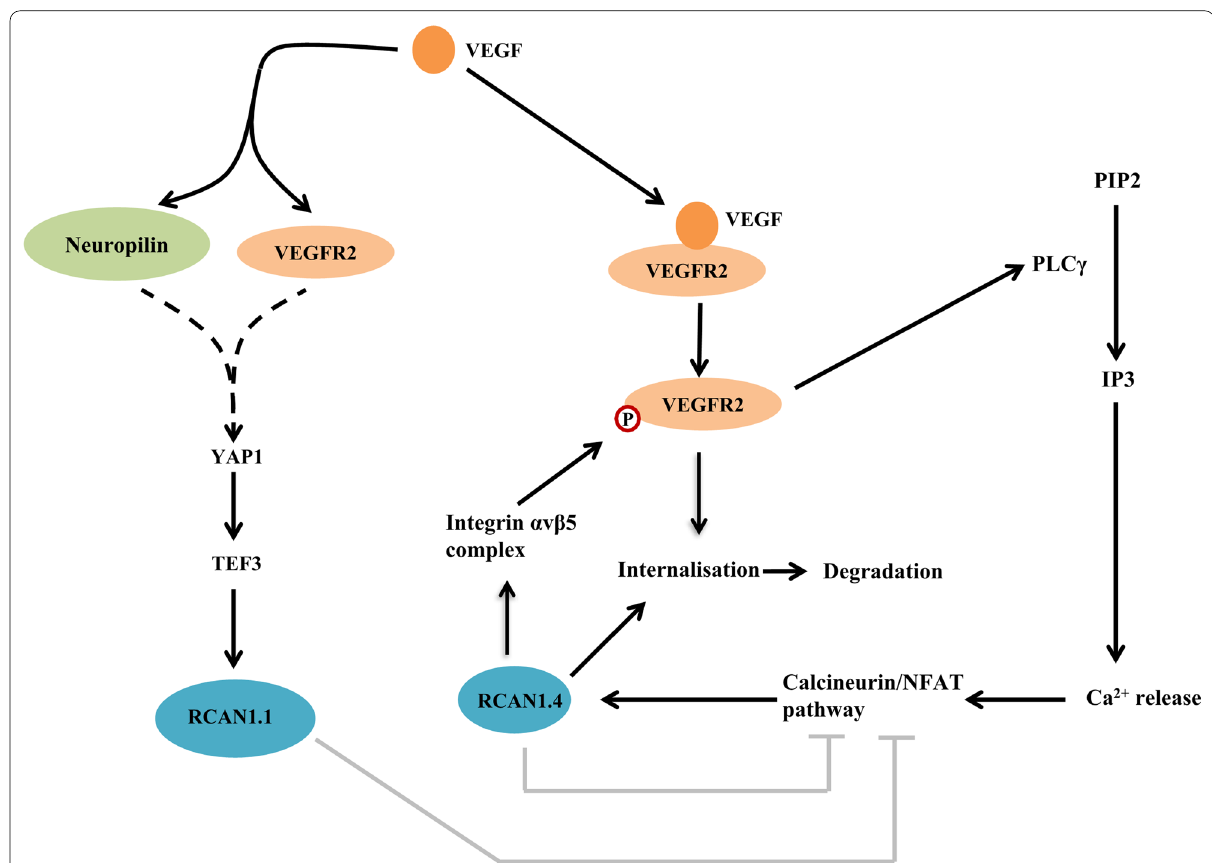
Fig. 2 RCAN1 in the regulatory network of VEGF-VEGFR2 signaling. VEGF induces RCAN1.1 upregulation via YAP1-TEF3 activation which is possibly mediated by neuropilin and VEGFR2. VEGF stimulation-induced VEGFR2 phosphorylation activates PLCγ, which cleavages PIP2 into IP3. IP3 enhances the release of Ca 2 + contributing to the activation of calcineurin/NFAT signaling, which promotes RCAN1.4 expression. On the other hand, both RCAN1.1 and RCAN1.4 participates in VEGF-VEGFR2 signaling via inhibiting calcineurin-NFAT signaling-mediated RCAN1.4 expression. RCAN1.4 facilitates VEGFR2 internalisation followed by proteolytic degradation, and facilitatesVEGFR2 phosphorylation possibly mediated by integrin αvβ5 complex. The arrowhead stands for positive regulation, while T-shaped end stands for inhibition. Dotted line stands for possible signaling pathways. P within the red circle represents the phosphorylation form of